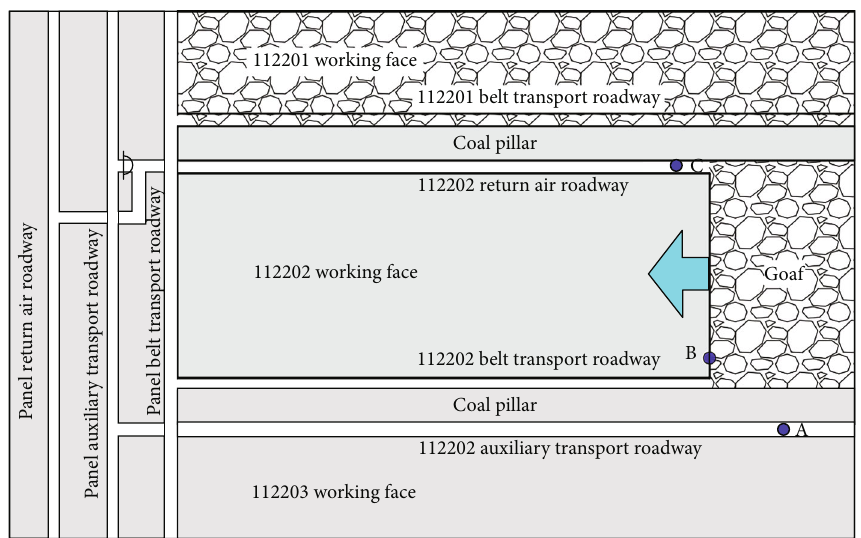
Figure 1: Location diagram of the roadway and working face.